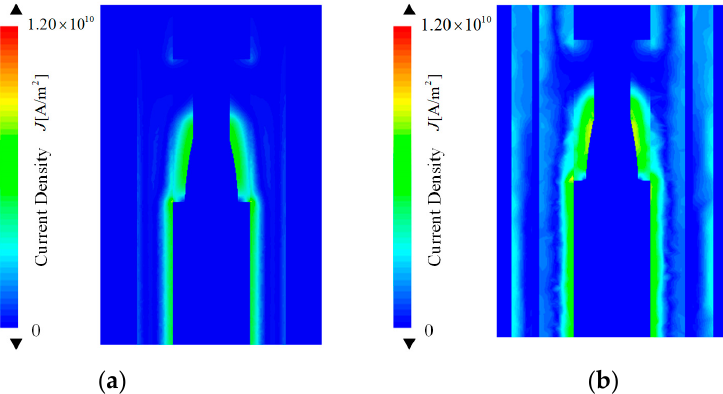
Figure 4. Axial section of magnetic field intensity distribution: ( a ) nonenhanced; ( b )